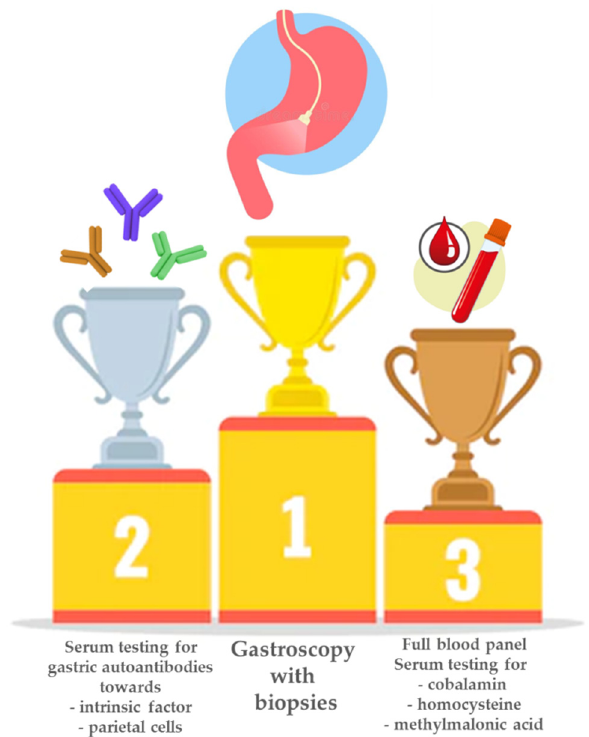
Figure 2. Mainstays in the diagnosis of pernicious anemia. When pernicious anemia is suspected, the first step is usually a full blood panel to test for anemia and/or macrocytosis, together with testing for cobalamin deficiency and increased levels of homocysteine and/or methylmalonic acid. Next, the positivity of gastric autoantibodies towards parietal cells and/or intrinsic factor is commonly assessed. In any case, the hematological and/or serological suspicion of pernicious anemia always needs to be confirmed by histological assessment of gastric antral and corpus biopsies obtained during gastroscopy.